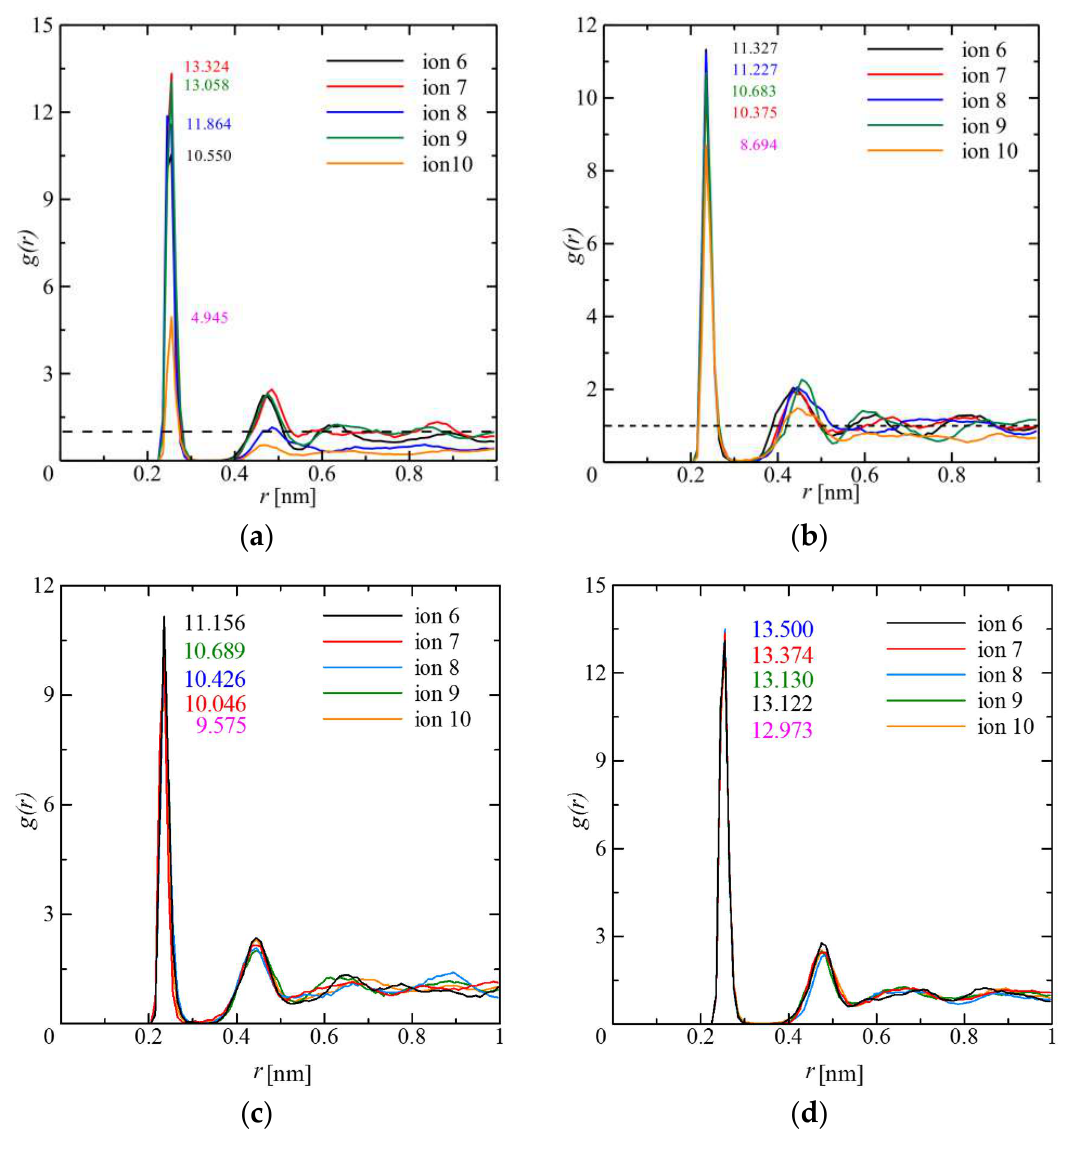
Figure 3. Radial distribution functions of water molecules around cations; ( a ) Sodium ions for 1500–1550 ps, ( b ) Calcium ions for 1500–1550 ps, ( c ) Sodium ions for 1950–2000 ps, ( d ) Calcium ions for 1950–2000 ps.